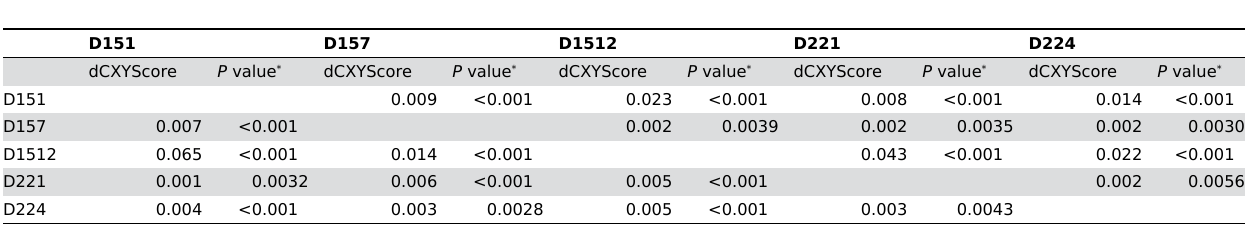
Table 5. LIBSHUFF analysis of the community structures of samples collected at D151, D157, D1512, D221, D224 at an OTU definition level of